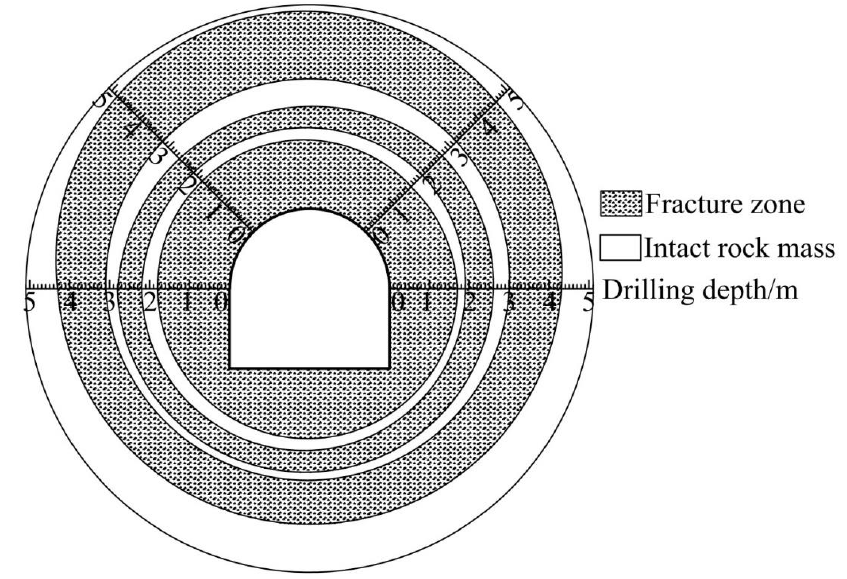
Figure 11. The zonal disintegration monitored in Section 1.